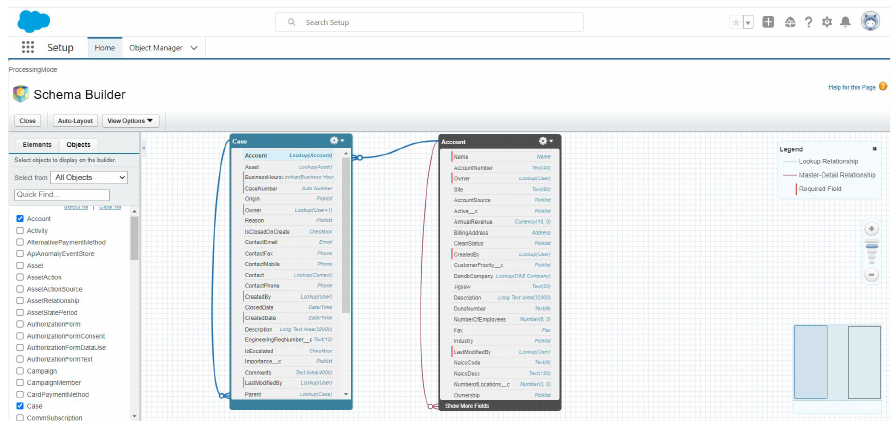
Figure 6. Salesforce CRM . Data Model for Ticket Management.